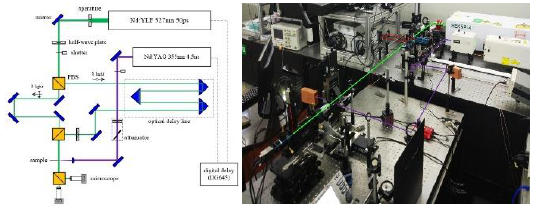
Fig.1 Schematic diagram of the TRPP